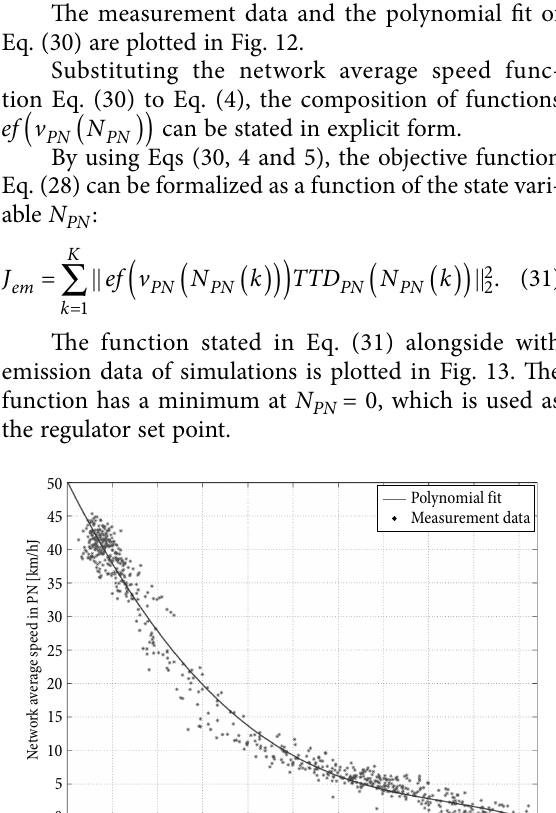
[PCE]0 Number of vehicles in PN Fig. 12. Network average speed function